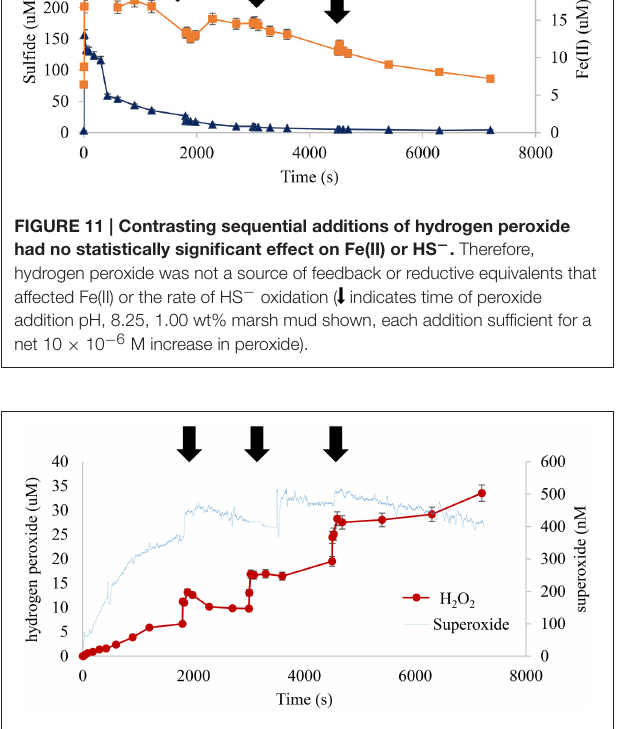
FIGURE 12 | Sequential hydrogen peroxide spikes were increasingly stable. The initial hydrogen peroxide addition decayed rapidly while the latter two were essentially stable additions, indicating that peroxide-consuming reactions were still taking place at the time of first addition. ( indicates time of peroxide addition pH, 8.25, 1.00wt% marsh mud shown, each addition sufficient for a net 10 × 10 − 6 M increase in